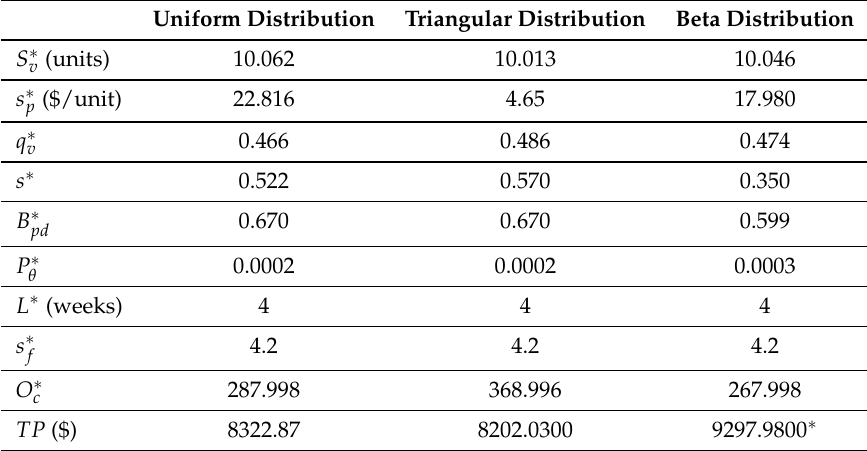
Table 5. Optimum values without service